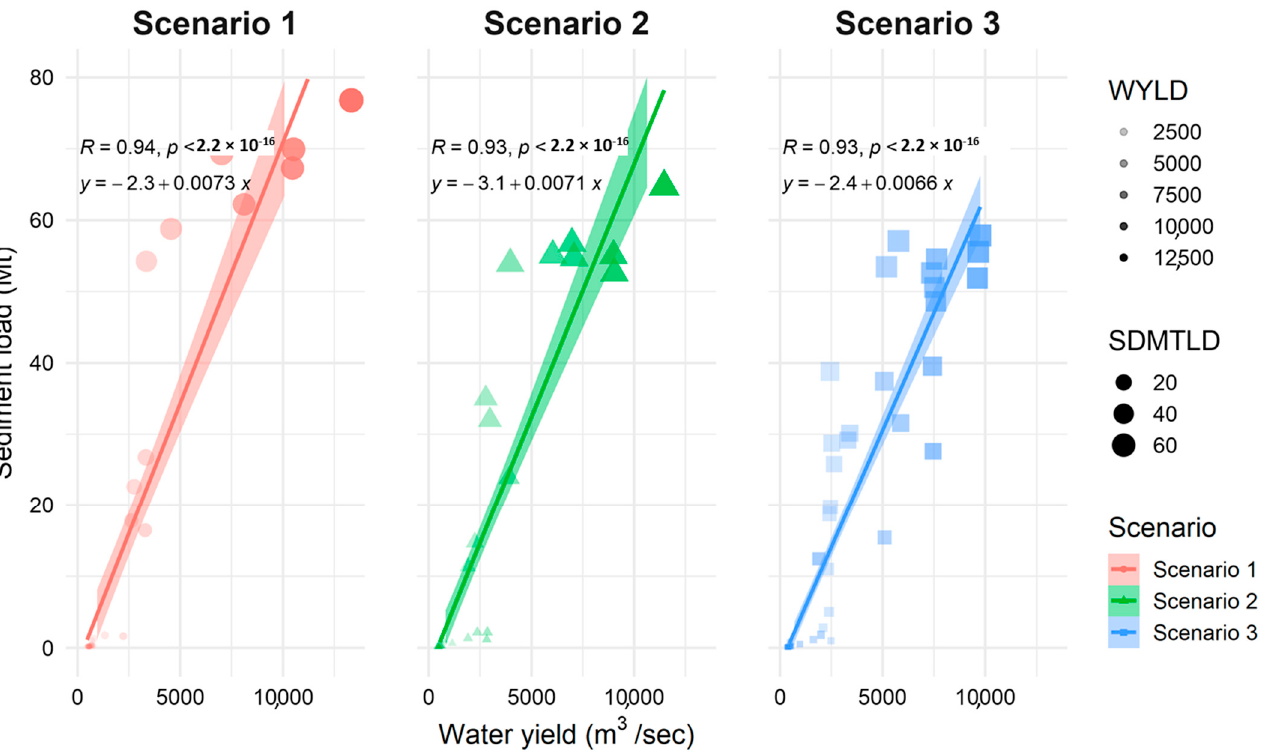
Figure 10. Relationship between the water yield and sediment load under the first (2013), second (2017), and third (2025)